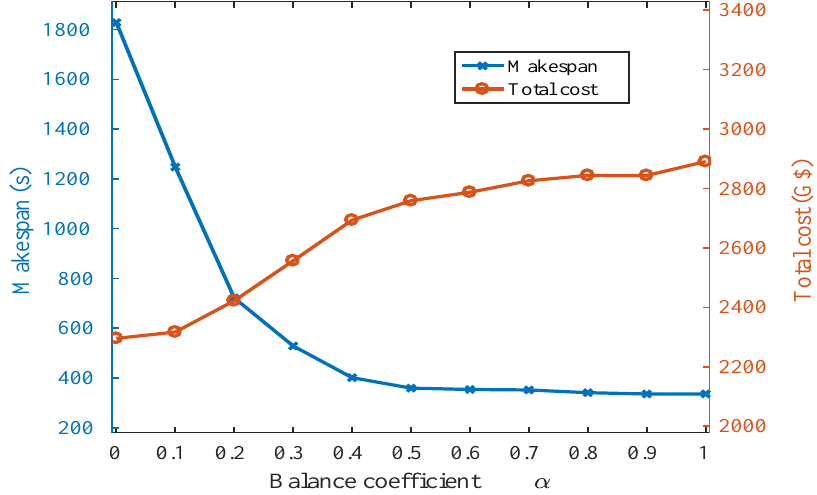
Figure 8. Time and cost as the balance coefficient α